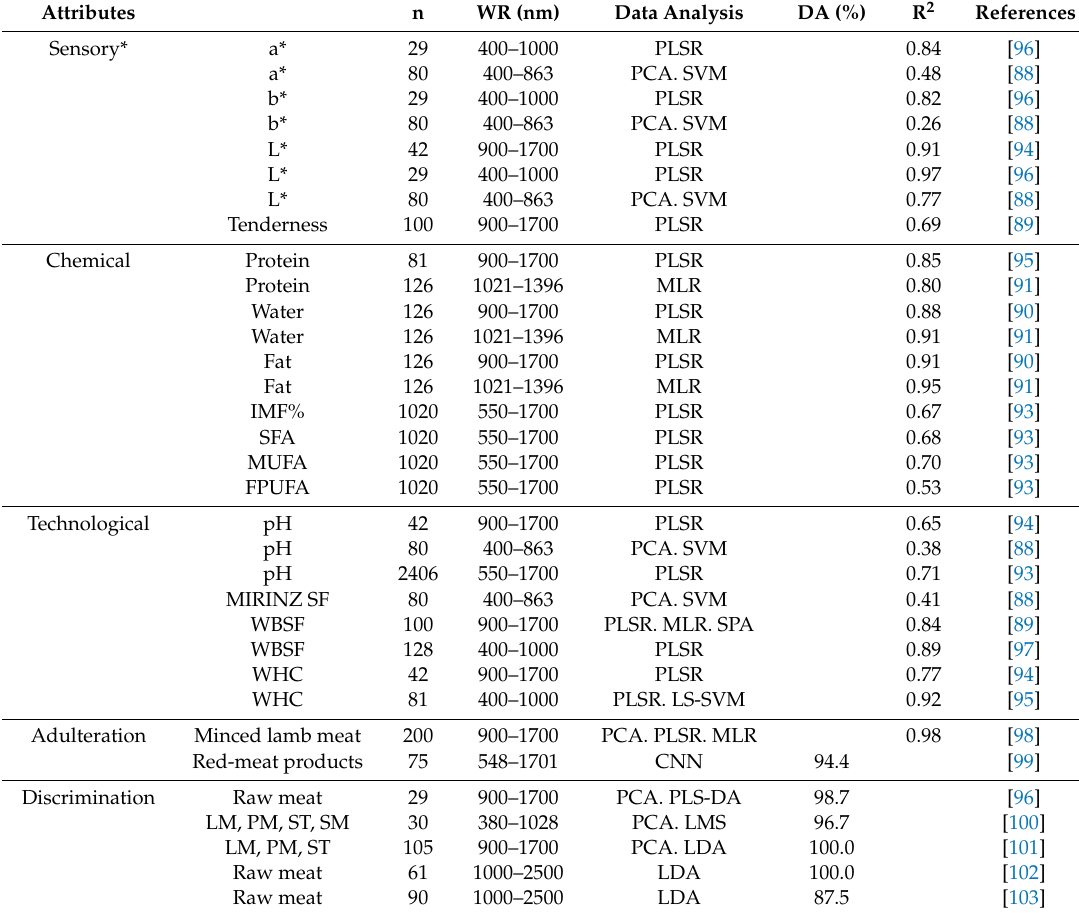
Table 6. Summary of applications of HSI for evaluating quality attributes of sheep